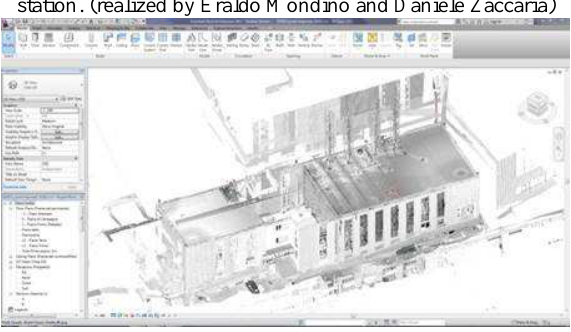
Figure 4. Point Clouds of the old thermal power.